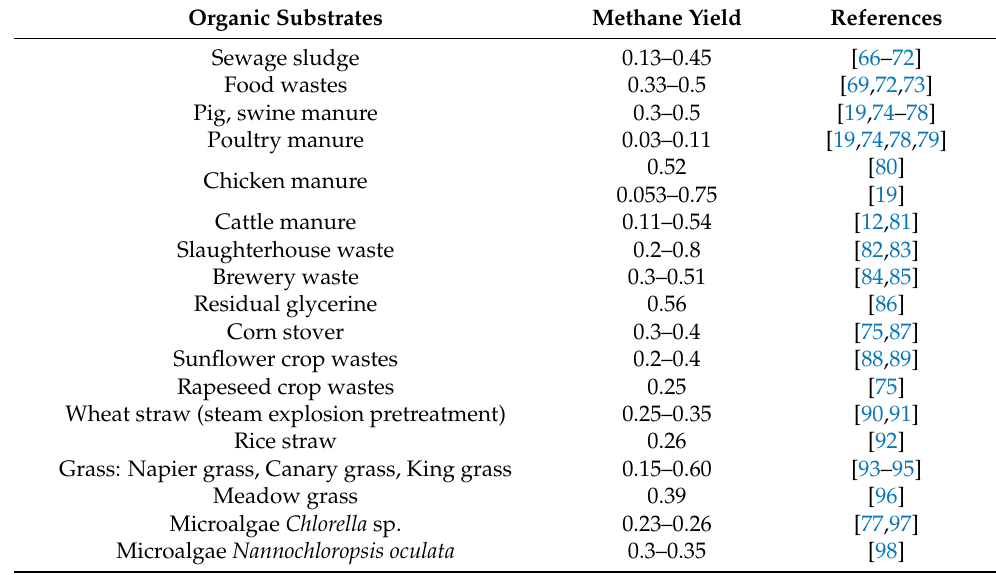
Table 1. Methane yields reported by different authors when evaluating individual